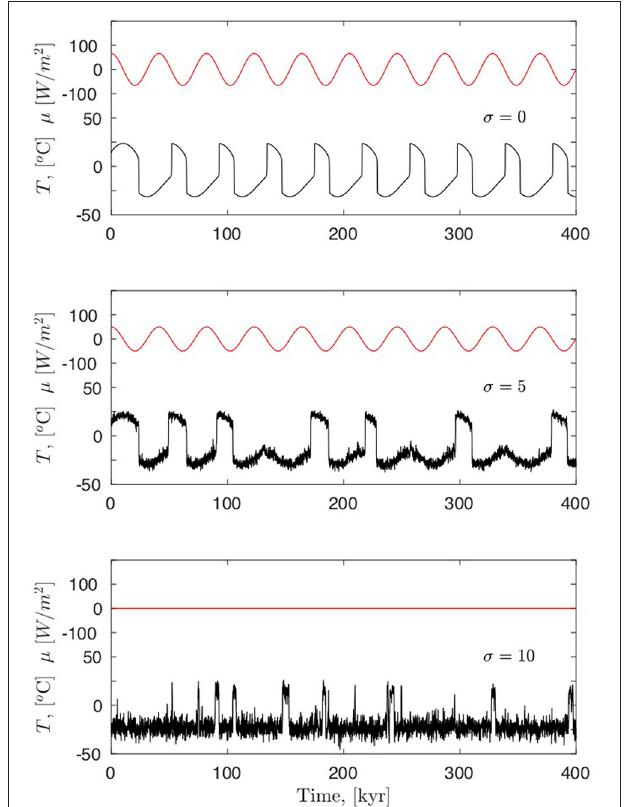
FIGURE 3 | The non-linear response of the energy balance model for the climate (1) to harmonic variations in the insolation: µ ( t ) = µ 0 cos ω t when µ 0 is large enough for crossing the two bifurcation points.(top panel). With a noise component with intensity σ (2) added, the response is at the frequency of the forcing, even though the forcing itself does not cause crossing of the bifurcation points. This is called stochastic resonance (middle panel). If the noise intensity is large enough, even without periodic forcing, the system will jump stochastically as a Poisson process with little sign of periodicity. This is termed noise induced transitions (bottom